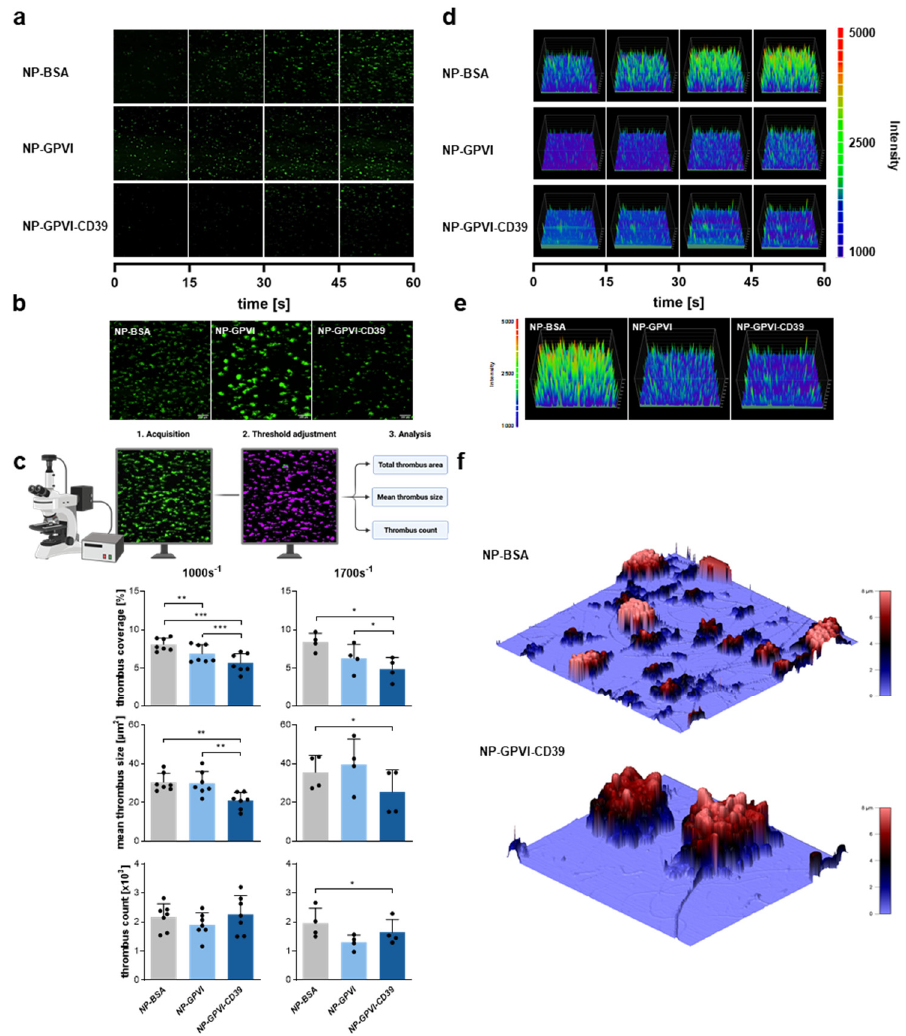
Figure 7. Interference of receptor-coated nanoparticles with thrombus formation under dynamic conditions. ( a ) Representative time-series images of flow chamber experiments depicting thrombus formation on collagen-covered cover slips after pre-incubation with nanoparticles, scale bar = 100 µ m. ( b ) Representative fluorescence microscopic images of thrombus formation after perfusion, scale bar = 100 μ m. ( c ) Schematic presentation of the analytical process of the conducted perfusion experiments. Created with BioRender.com; accessed on 17 June 2021). Statistical analysis of thrombus coverage, mean thrombus size and thrombus count at both low (1000 s − 1 ) and high (1700 s − 1 ) shear rates. Mean ± SD; 1000 s − 1 : n = 7, 1700 s − 1 ; n = 4; one-way ANOVA, * p ≤ 0.05, ** p ≤ 0.01, *** p ≤ 0.001. ( d ) Time series of intensity surface plots representing the acquired flow chamber data. ( e ) Representative intensity surface plots of the completed perfusion experiments. ( f ) Topographical display of thrombus-covered cover slips after completed perfusion at a high shear rate (1700 s − 1 ), produced by scanning ion-conductance microscopy (SICM).